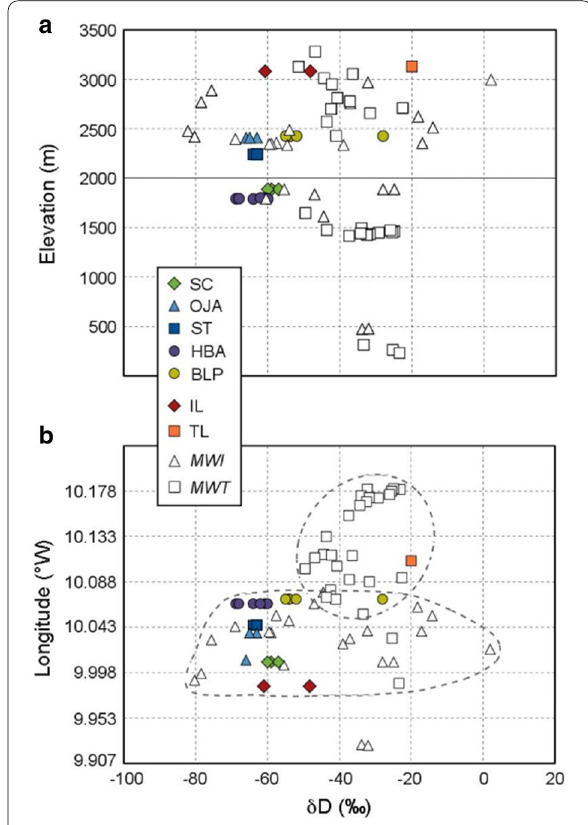
Fig. 6 Plots of δD vs elevation ( a ) and longitude ( b ) for the thermal springs and Irazú–Turrialba lake waters compared with meteoric waters for Irazú (MWI) and Turrialba (MWT). In b the gray dotted fields illustrate the bulk of Irazú and Turrialba meteoric water